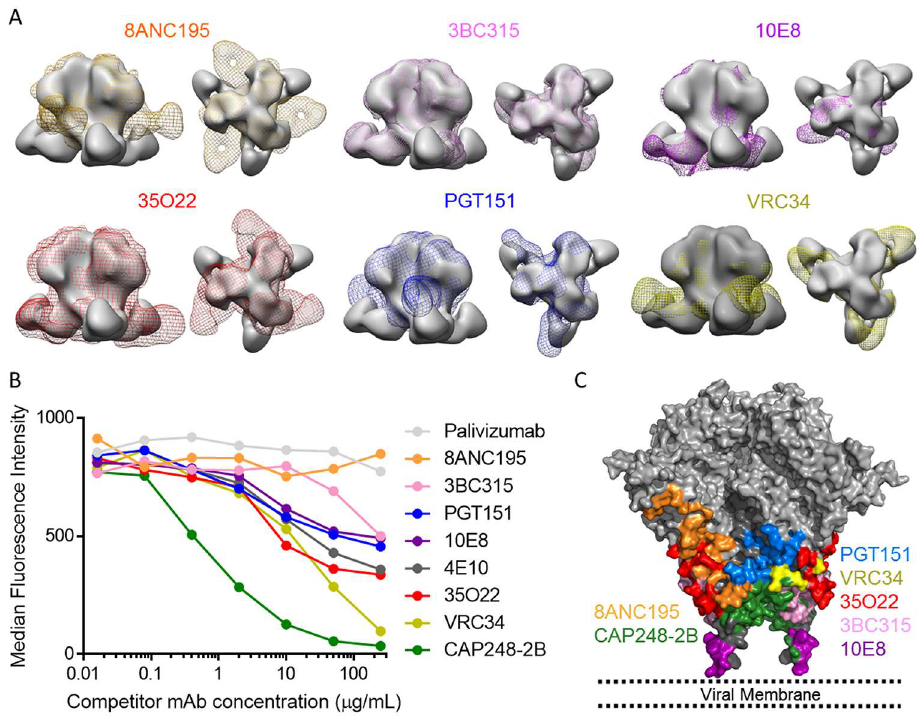
Fig 6. Broadly neutralizing antibodies that target gp41 compete with CAP248-2Bfor binding to cell- surfaceEnv. (A) Comparisonsof gp41 directed bNAbs bound to SOSIP trimers by EM. The CAP248-2B bound trimers are shown in solid grey surface, while8ANC195,3BC315,10E8, 35O22, PGT151, and VRC34 bound trimers are shown with mesh representation. Both top views and side views are shown. (B) Bindingof labelledCAP248-2B to cell-surface anchoredHIV-1 Env by flow cytometry, in the presenceof increasing concentrations of unlabeledcompetitor antibody.Median fluorescence intensity (MFI) is shown on the y-axis, and increasing concentrations of each competitor antibodyis plotted on the x-axis. DecreasingMFI signals correspond to increasing competitionwith CAP248-2B. (C) Surface view of the envelopetrimer with modelled MPER, coloredto show the core epitopesfor gp41 targeted bNAbs. The approximate location of the viral membraneis